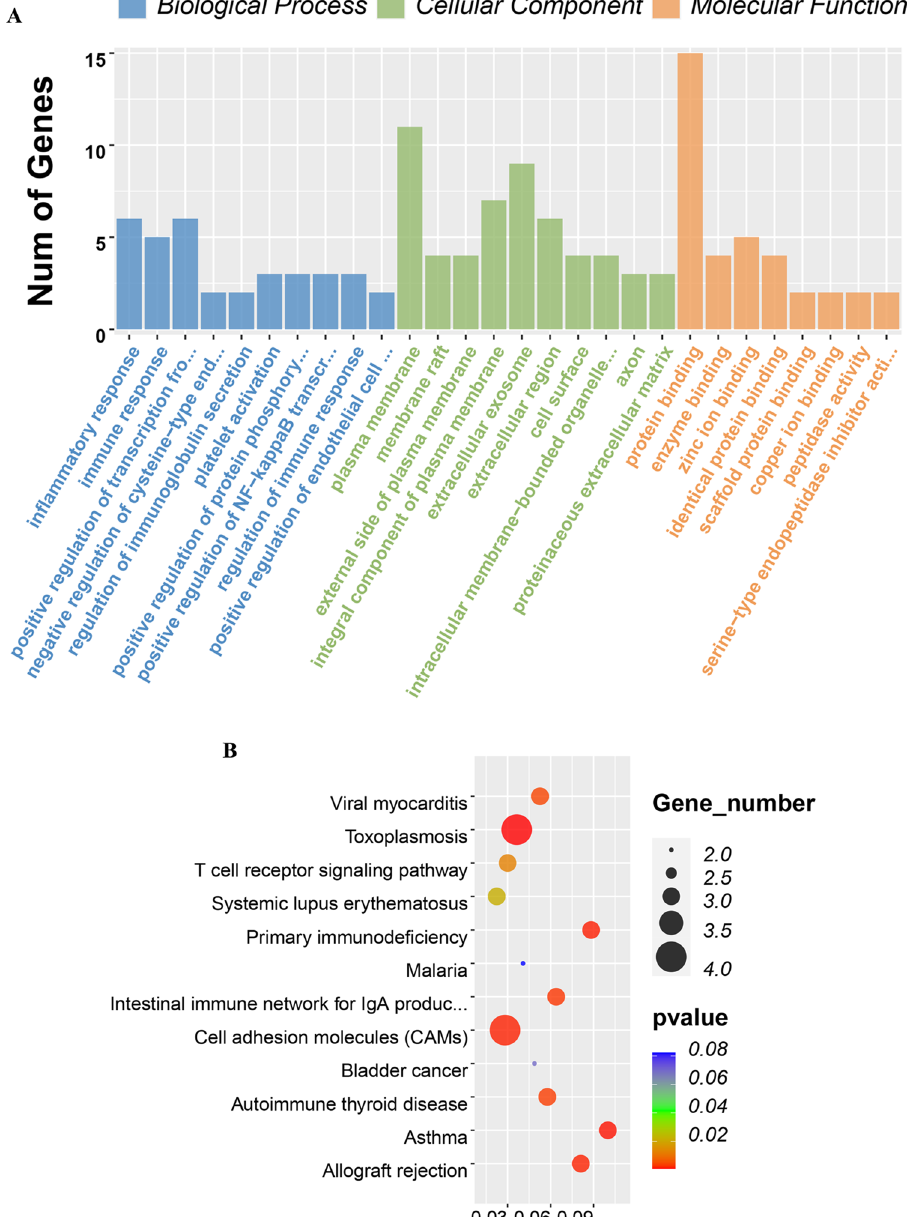
Figure 3. GO term and KEGG pathway analysis for DEGs significantly associated with unstable angina and obstructive sleep apnea. ( A) Top 10 GO terms. Number of gene of GO analysis was acquired from DAVID functional annotation tool. p < 0.05. ( B) KEGG